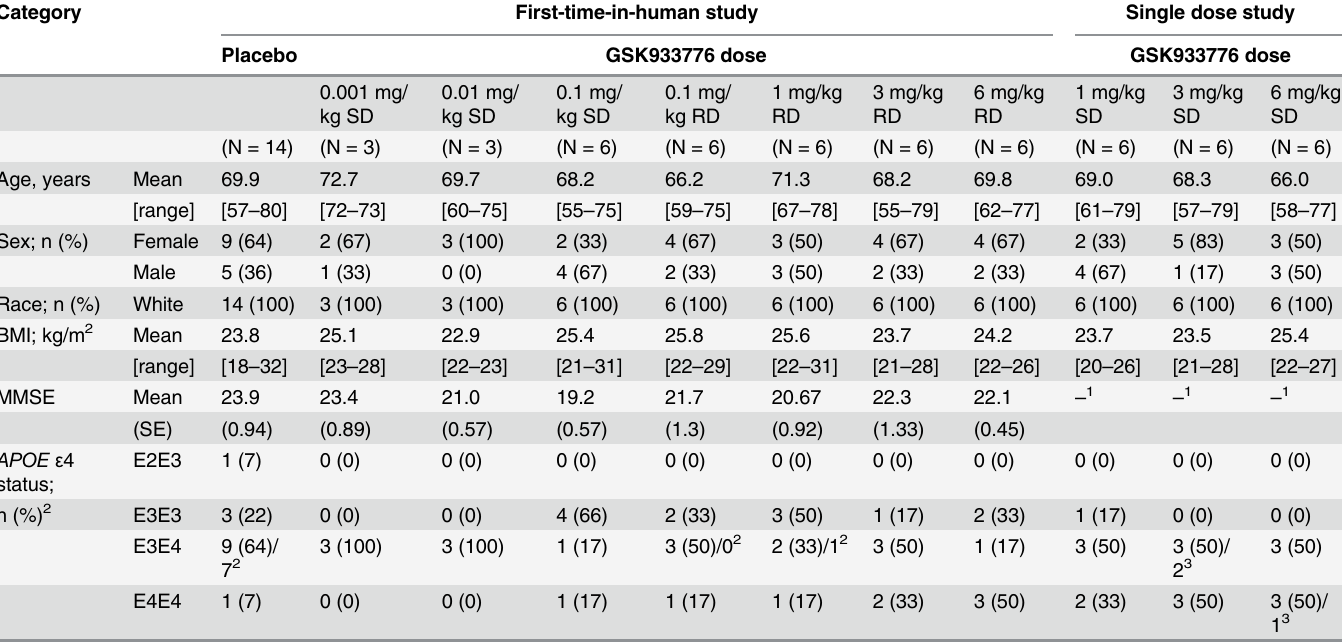
Table 1. Summary of patients ’ baseline characteristics.